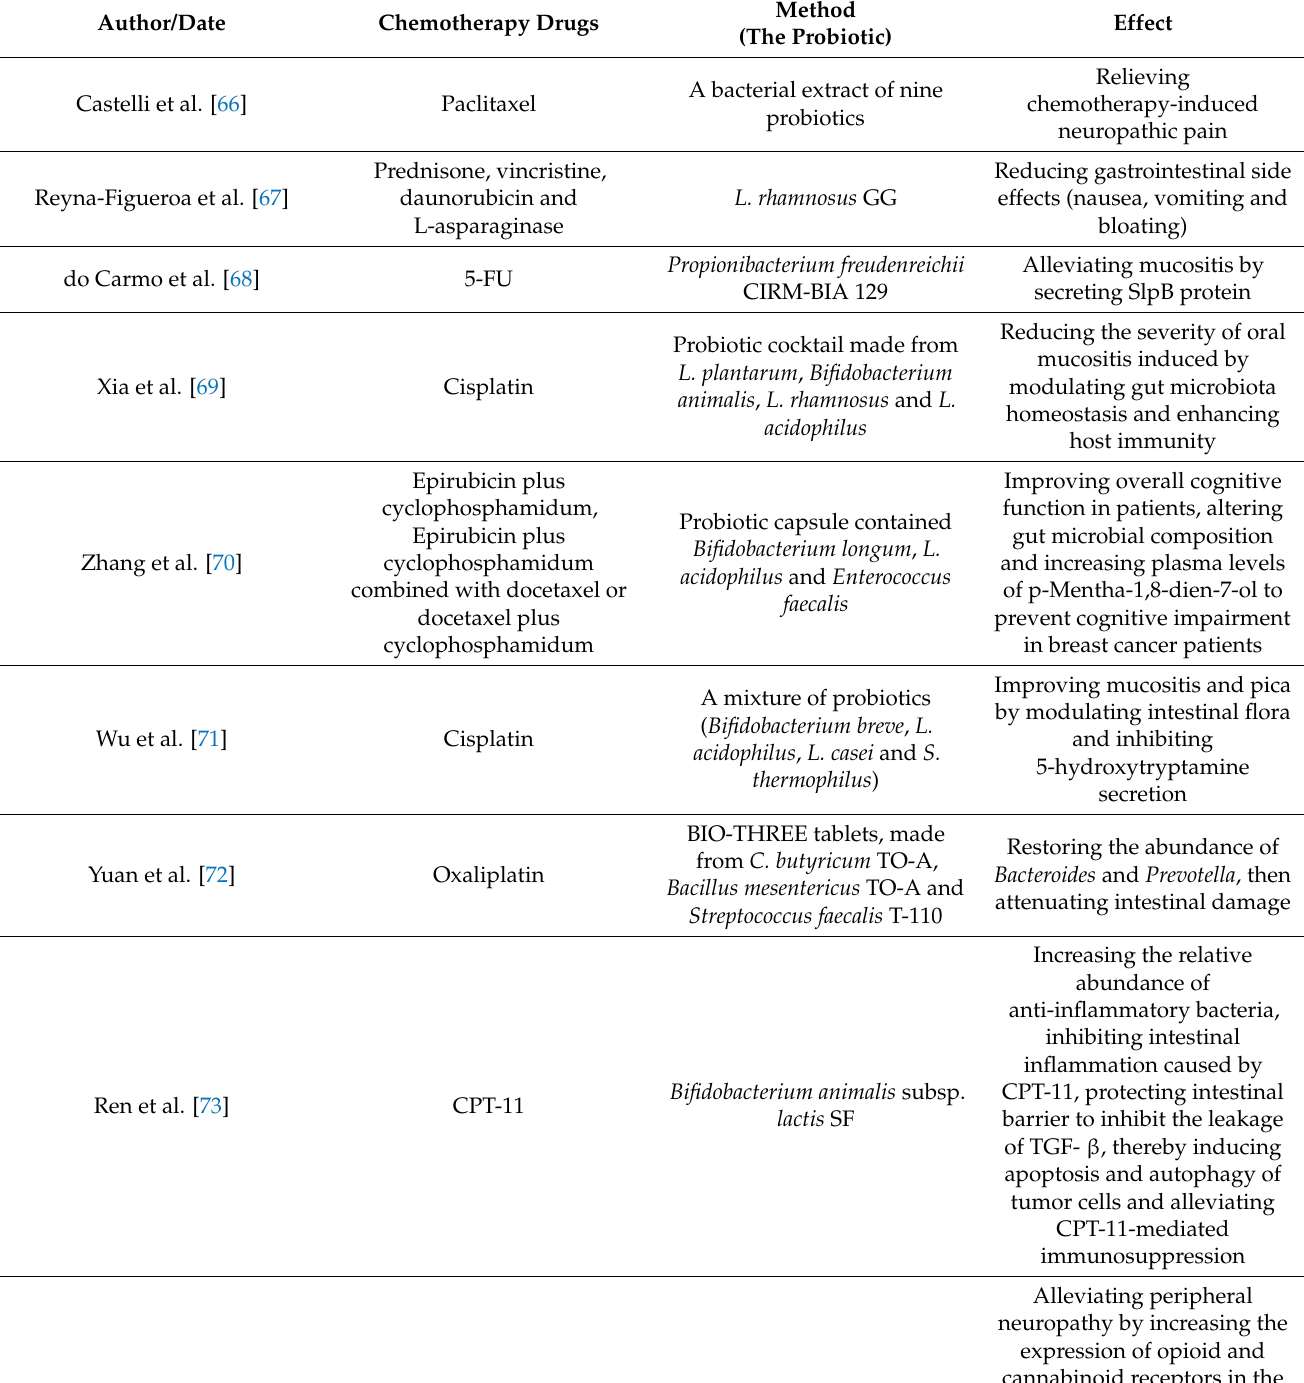
Table 3. Recent studies on the efficacy of probiotics in alleviating side effects of